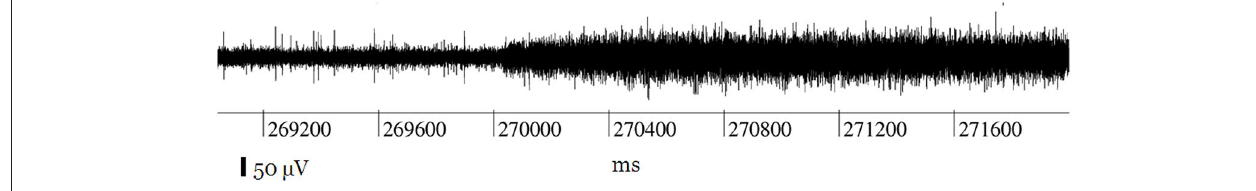
FIGURE 9 | Record of a channel showing the typical effect of connection disruption leading to noise during neural recording: the spikes are lost in increased background noise. Figure adapted with permission from Krüger et al. (2010). Connection disruptions are reparable with engineering